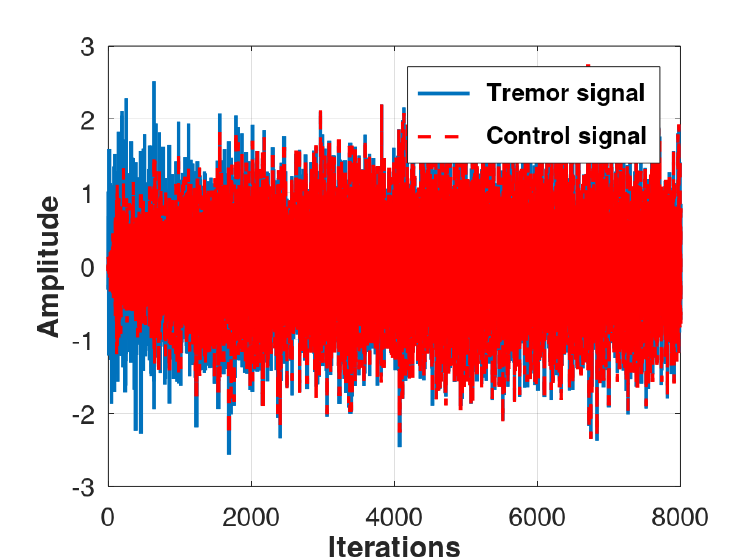
Figure 10. Control evaluation by the Fx-LMS–NLMS algorithm for 30 runs of a Monte Carlo simulation.